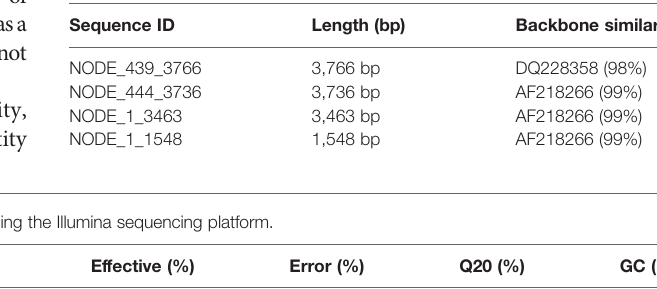
TABLE 4 | List of longest contigs with similarity to IHHNV genome